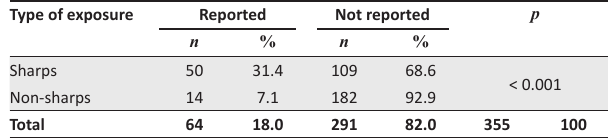
TABLE 3: Proportions of exposures reported and unreported.